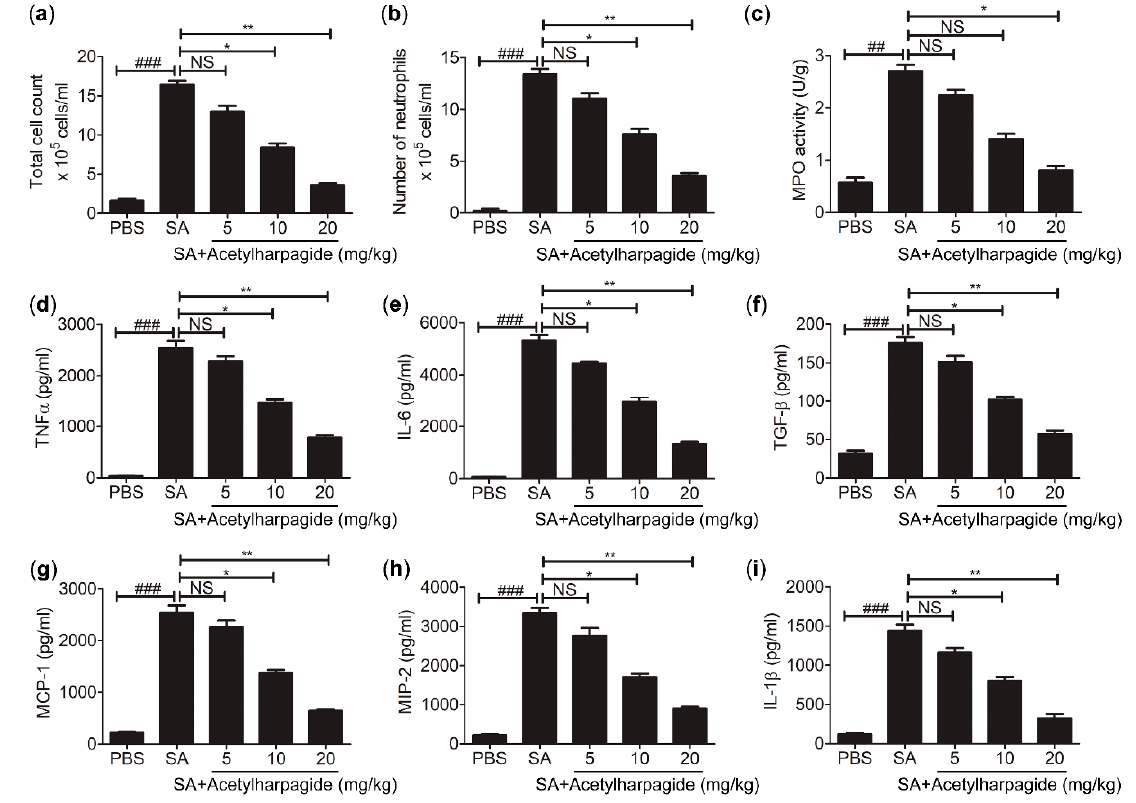
Figure 4. Acetylharpagide attenuated S. aureus (SA)-induced inflammation. ( a , b ) The number of total cells and neutrophils in BAL fluid were counted at 12 h after S. aureus infection; ( c ) The myeloperoxidase (MPO) activity of lung homogenate was measured by ELISA at 12 h after S. aureus infection; ( d – i ) ELISA was performed to measure the concentrations of TNF- α ( d ), IL-6 ( e ), TGF- β ( f ), MCP-1 ( g ), MIP-2 ( h ) and IL-1 β ( i ) in BAL fluid at 12 h after S. aureus infection. The data were presented as mean ± SD, ## p < 0.01, ### p < 0.001 vs. PBS + DMSO group, * p < 0.05, ** p < 0.01 vs. SA + DMSO group, n = 6–8.